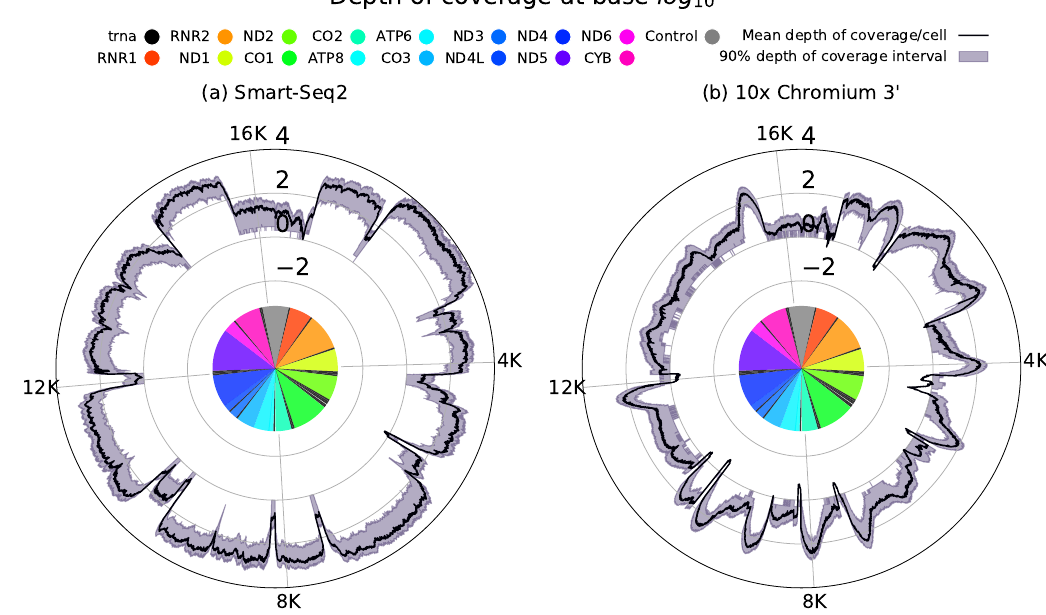
Figure 2. Sequencing protocols demonstrate a high degree of variation in both depth and breadth of coverage they attain across the mitochondrial genome. ( a ) Full-length Smart-Seq2 data [32] demonstrates broadly uniform coverage across transcript lengths. 10 × 3 (cid:48) protocols achieve a far higher throughput of cells, than full-length approaches. ( b ) However, 10 × 3 (cid:48) data [31] has a poorer breadth of coverage of the mitochondrial genome due to reads preferentially capturing the 3 (cid:48) poly A tails of transcripts. This results in the pronounced depth of coverage which can be observed in the 3 (cid:48) end of each gene. High throughput combined with consistent 3 (cid:48) coverage could enable 3 (cid:48) data to facilitate the discovery of mitochondrial heterogeneity. Such coverage plots can be generated by counting the reads aligned to each position in the mitochondrial genome in each individual